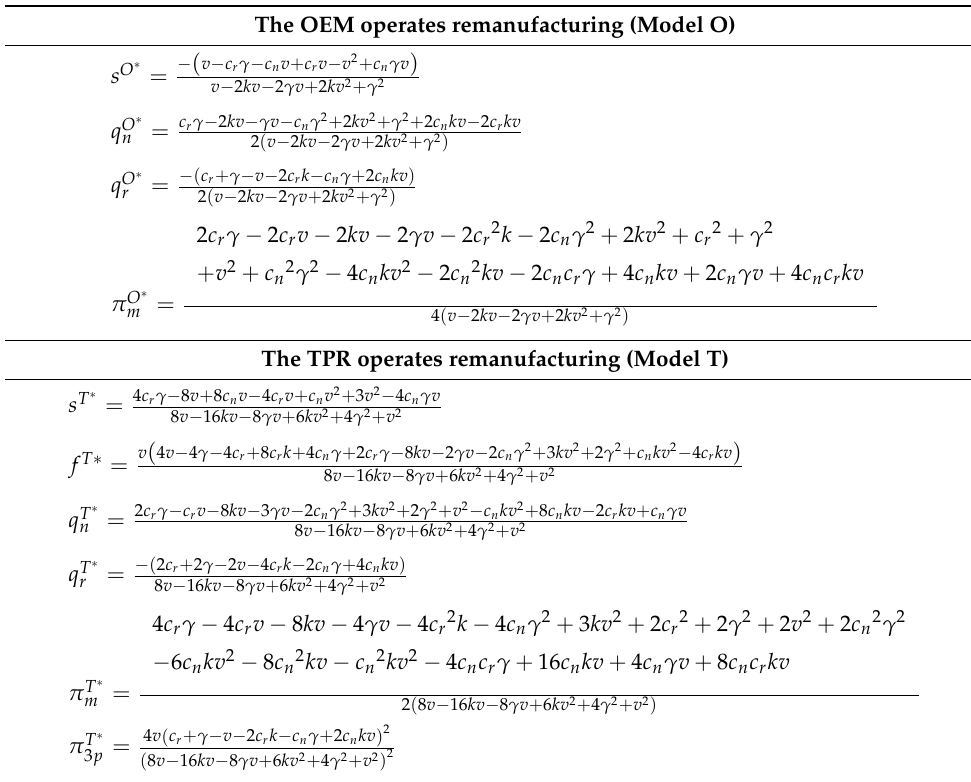
Table 3. Equilibrium decisions and